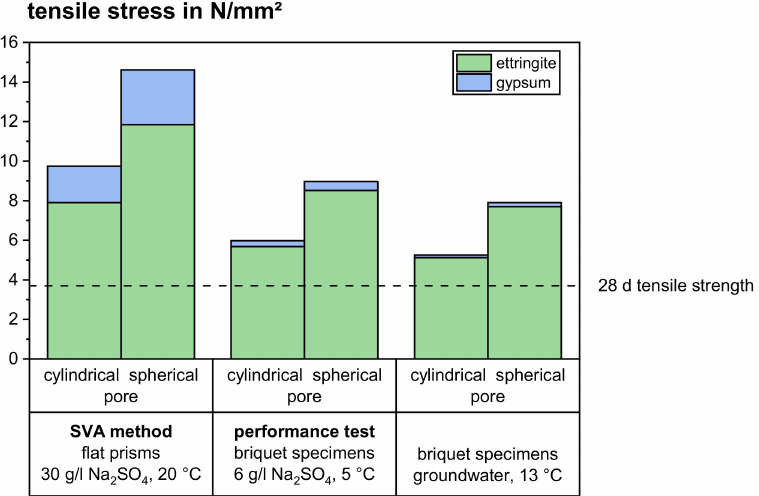
Figure 12. Calculated tensile stress exerted by additional crystallization of ettringite and gypsum induced by sulfate